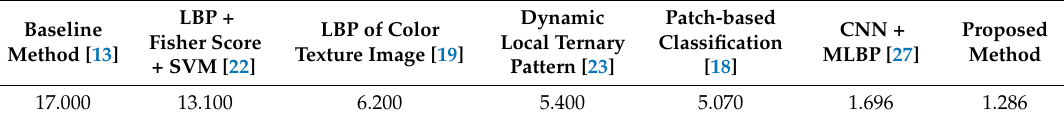
Table 9. Comparison of detection error (ACER) of our proposed method with various previous studies (unit: